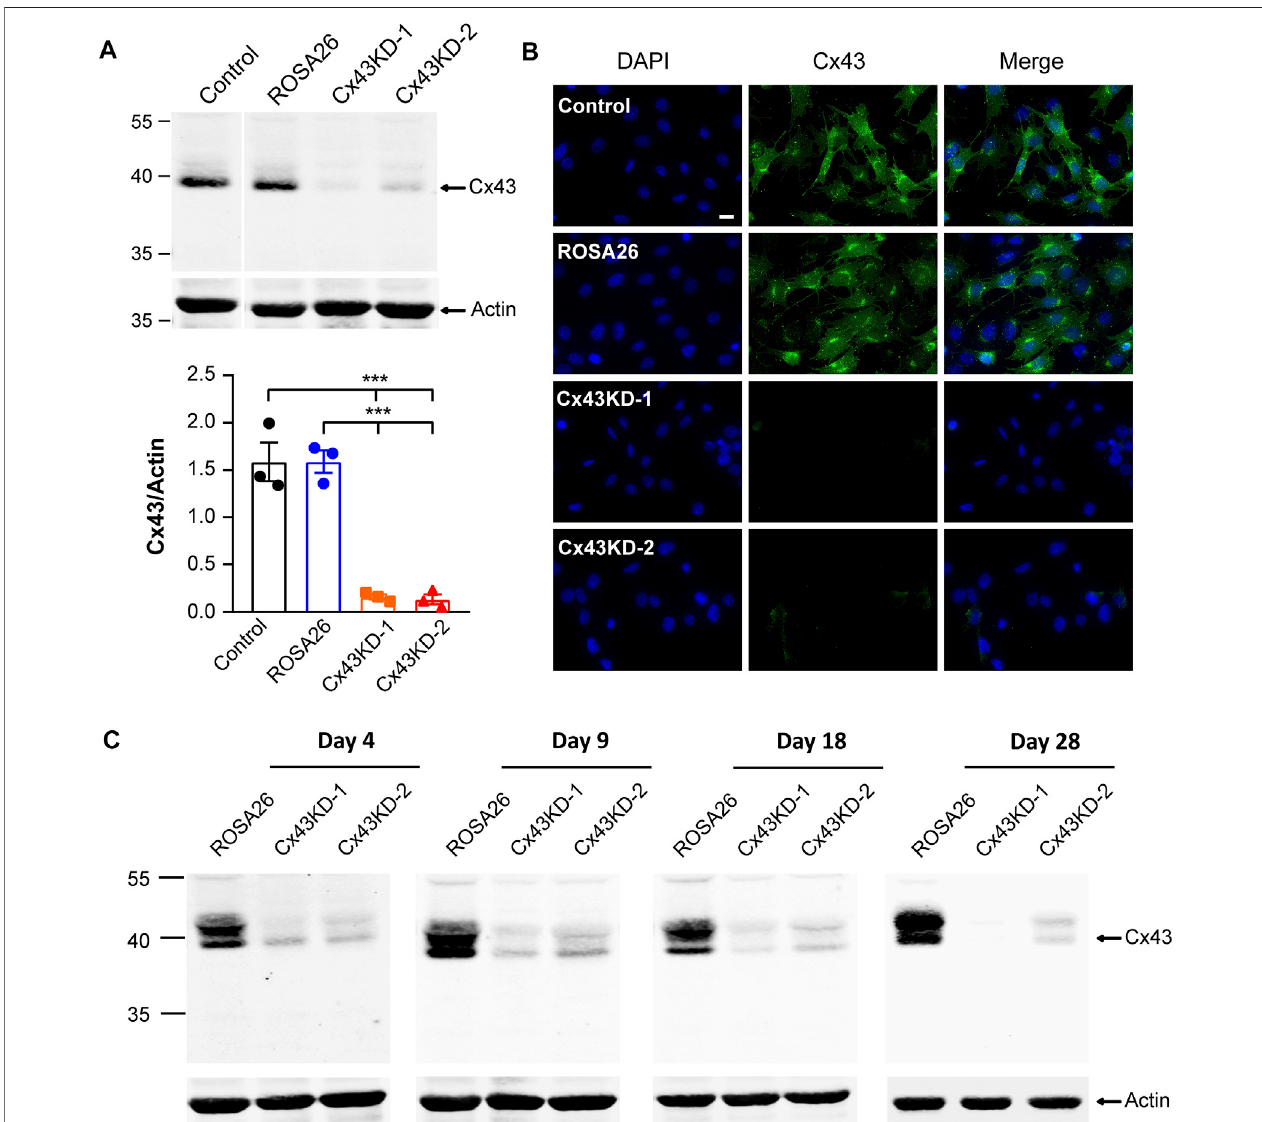
FIGURE2| AblationofCx43expressionusingCRISPR/Cas9geneeditingtechnologyinIDG-SW3cellline. (A) Immortalizing(Day0)IDG-SW3cellsweresubjected to speci fi ed ROSA26 or Cx43-sgRNA lentivirus transduction and puromycin selection. Membrane extracts were immunoblotted by Cx43 or β -actin antibodies (upper panel). The lower panel shows the densitometric measurement ratios of Cx43 to β -actin. (B) Representative images of Cx43 immuno fl uorescence staining in control, ROSA26,orCx43KDIDG-SW3cells.Scalebar,20 μ m. (C) MembraneextractswereisolatedfromROSA26orCx43KDgroupsduringthetimecoursefromDay4 to Day 28 after differentiation. Cx43 expression was analyzed by using Western blot probed with Cx43 and β -actin antibodies. Data shown are mean ± SEM. ***, p < 0.001.